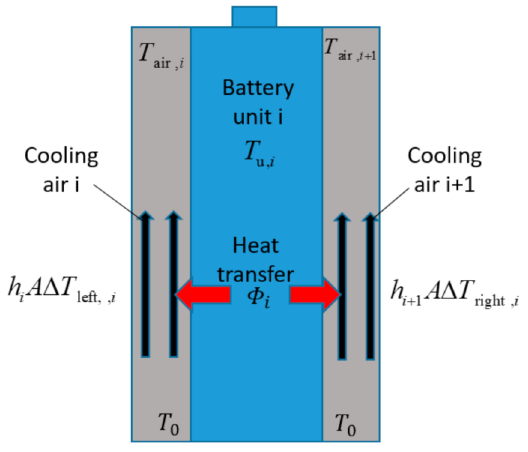
Figure 4. Heat transfer between the battery unit and the air. Table 1. Values of Y and y under various Reynold numbers in Equation